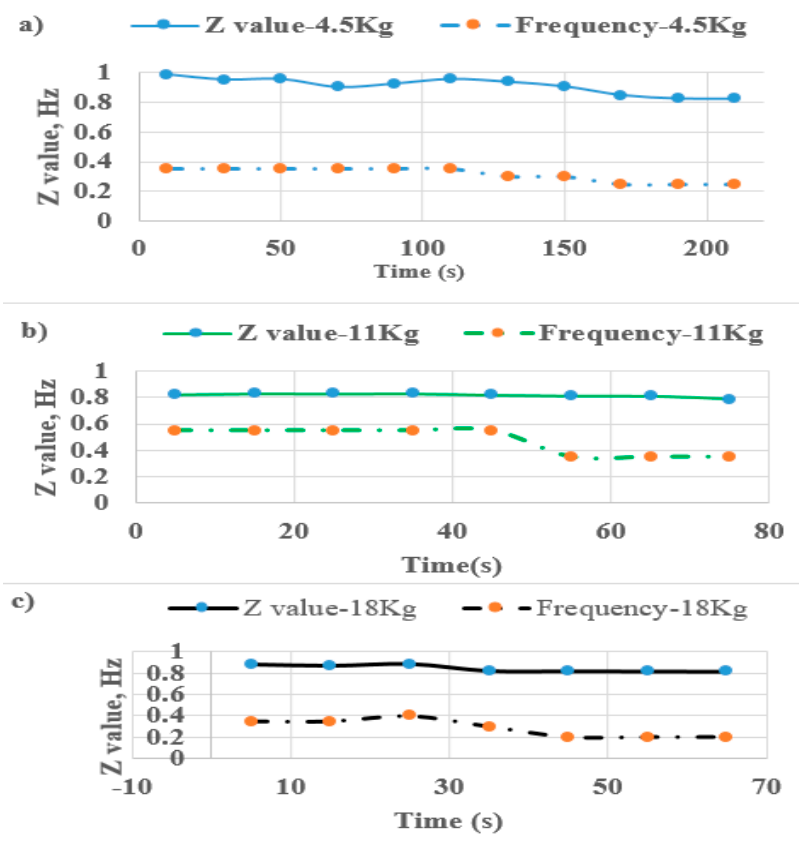
Figure 14. Leg raising frequency and force of subject A under various loads: ( a ) 4.5 kg, ( b ) 11 kg, ( c ) 18 kg. ( c ) 18